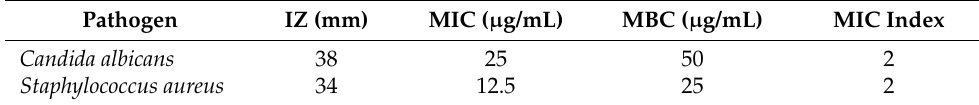
Table 8. Antimicrobial activity of the synthesized NFHDE/AK extract. Pathogen